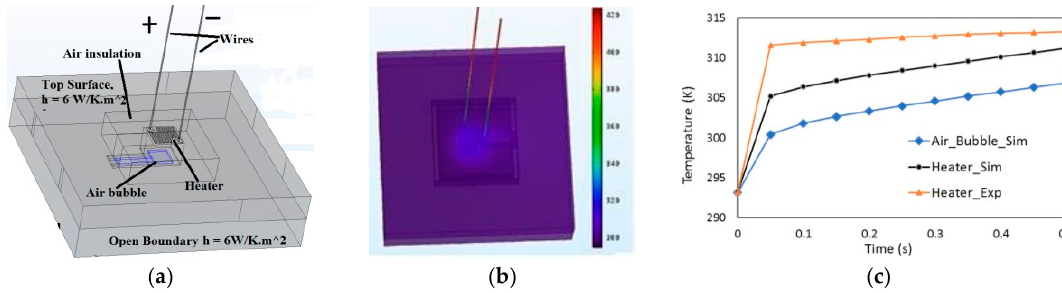
Figure 2. ( a ) Computational domain with boundary conditions, ( b ) temperature contours of the chip at t = 0.35 s and ( c ) temperature variation of bubble, and heater (both simulation and